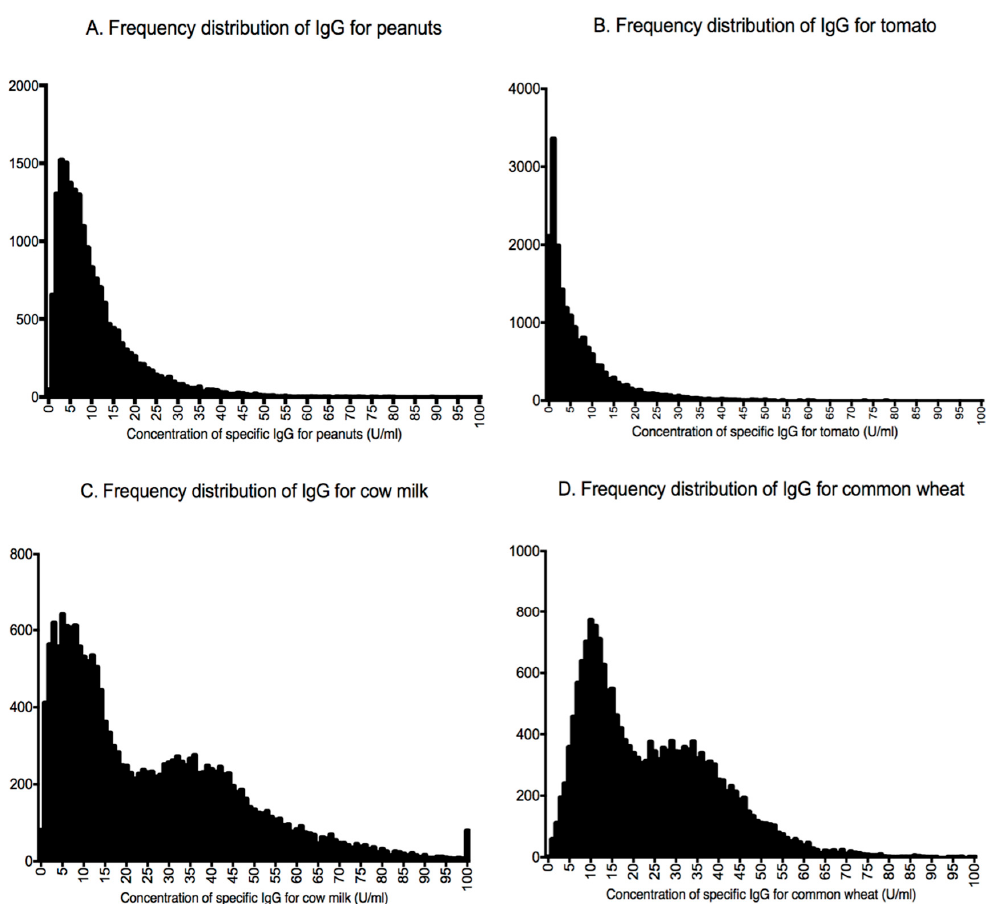
Figure 1. Examples of asymmetrical and bimodal distribution of frequencies for food-specific IgG. ( A , B ) Graphs showing two examples (for peanuts and tomato, respectively) of asymmetrical distribution of IgG. ( C , D ) Graphs showing two examples (for cow’s milk and common wheat, respectively) of bimodal distribution of IgG.